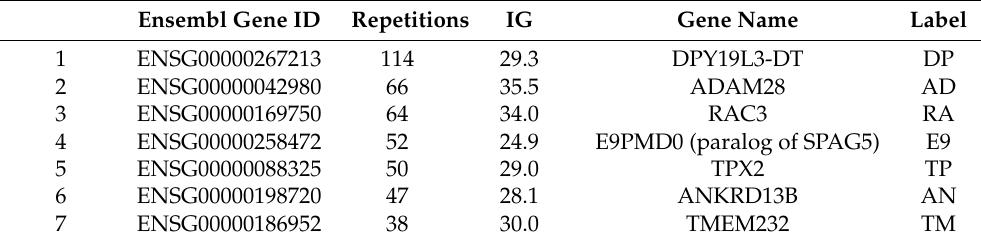
Figure 7. Heatmap of the correlation square of the chosen genes’ expression levels. The darker (more saturated) the square, the higher the level of correlation. Table 2. Details of the selected genes. The repetitions shown are for the case of selecting 7 clusters. There were 150 (30 times 5) trials, and thus, 150 is the upper bound for repetitions. IG stands for information gain, and here, it is the maximum IG computed by the MDFS library in 1D on the entire set (30 random discretizations were used). Label is a shortened version of gene name, used for identification purposes in other parts of the paper. Ensembl Gene ID Repetitions IG Gene Name